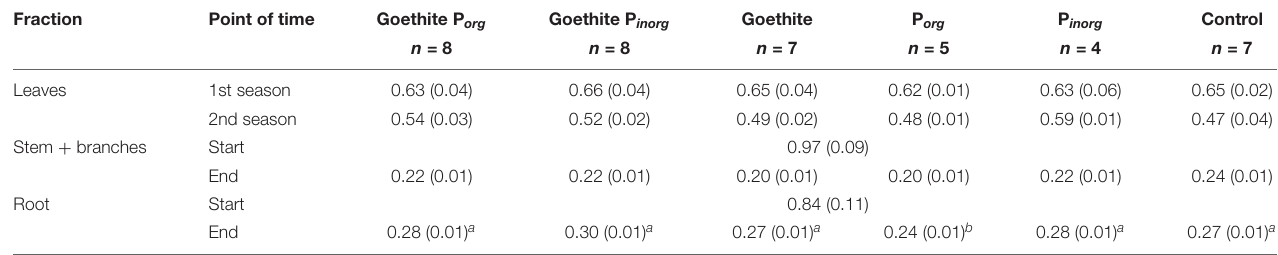
TABLE 4 | Phosphorus contents of beech fractions (mg g − 1 ) at the start ( n = 4 because one sample was lost during nutrient analysis) and end of the experiment. Fraction